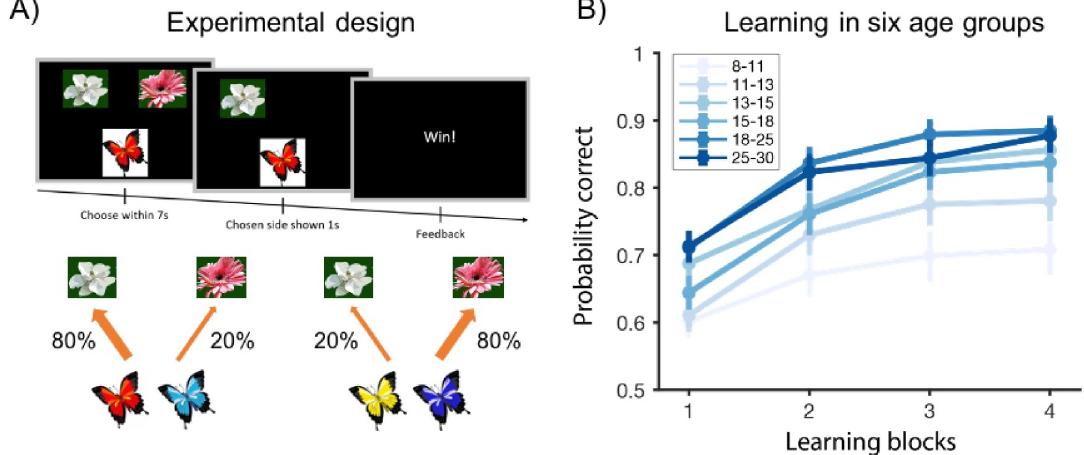
Fig 1. Experimental design and overall performance. (A) On each trial, participants needed to choose the butterfly’s preferred flower. Each butterfly’s preferred flower stayed the same throughout the experiment. If participants correctly picked the butterfly’s preferred flower, they observed a Win! feedback with 80% chance, and Lose! otherwise. The other choice delivered positive feedback only with 20% chance. Schematics were adapted from [2]. (B) Average probability of a correct choice over four 30-trial learning blocks. Learning curves showed all age groups learned the task, and that performance generally improved with age